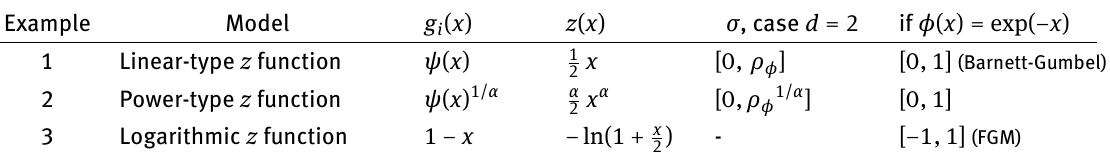
Table 2: Examples 1-3 of Archimatrix copula models for different choices of g i and z functions. Furthermore in the bivariate setting, the range for σ parameter is provided both in the general case and when ϕ ( x ) = exp(− x )